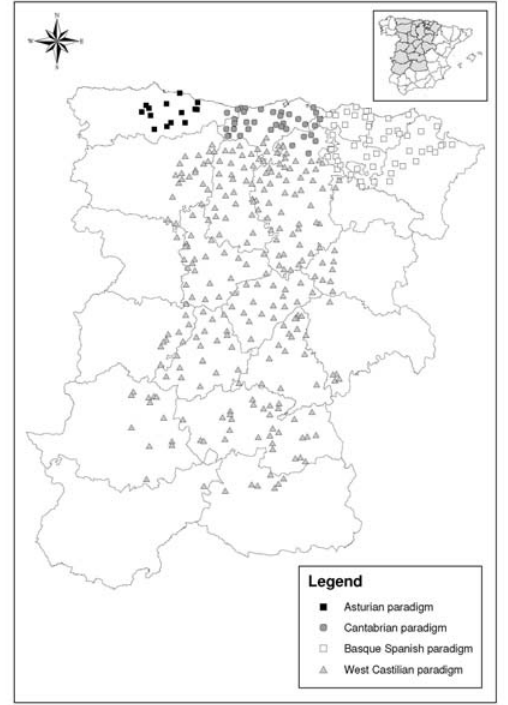
Map II: Referential pronominal system (Fernández-Ordóñez in